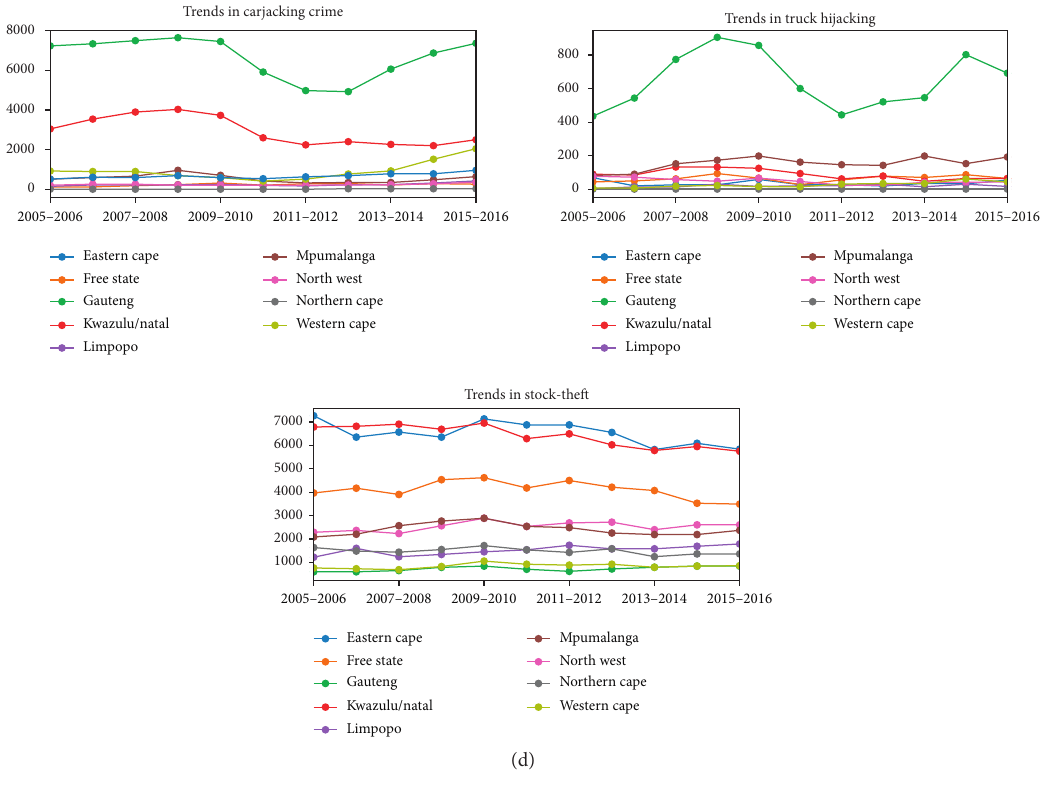
Figure 6: Trends in the 27 crime categories per province in 2005–2016.